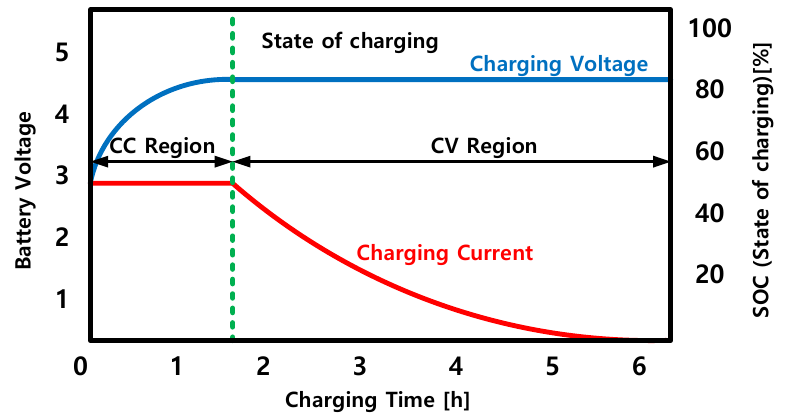
Figure 5. The characteristic of the CC-CV mode curve. Electronics 2019 , 8 , x FOR PEER REVIEW